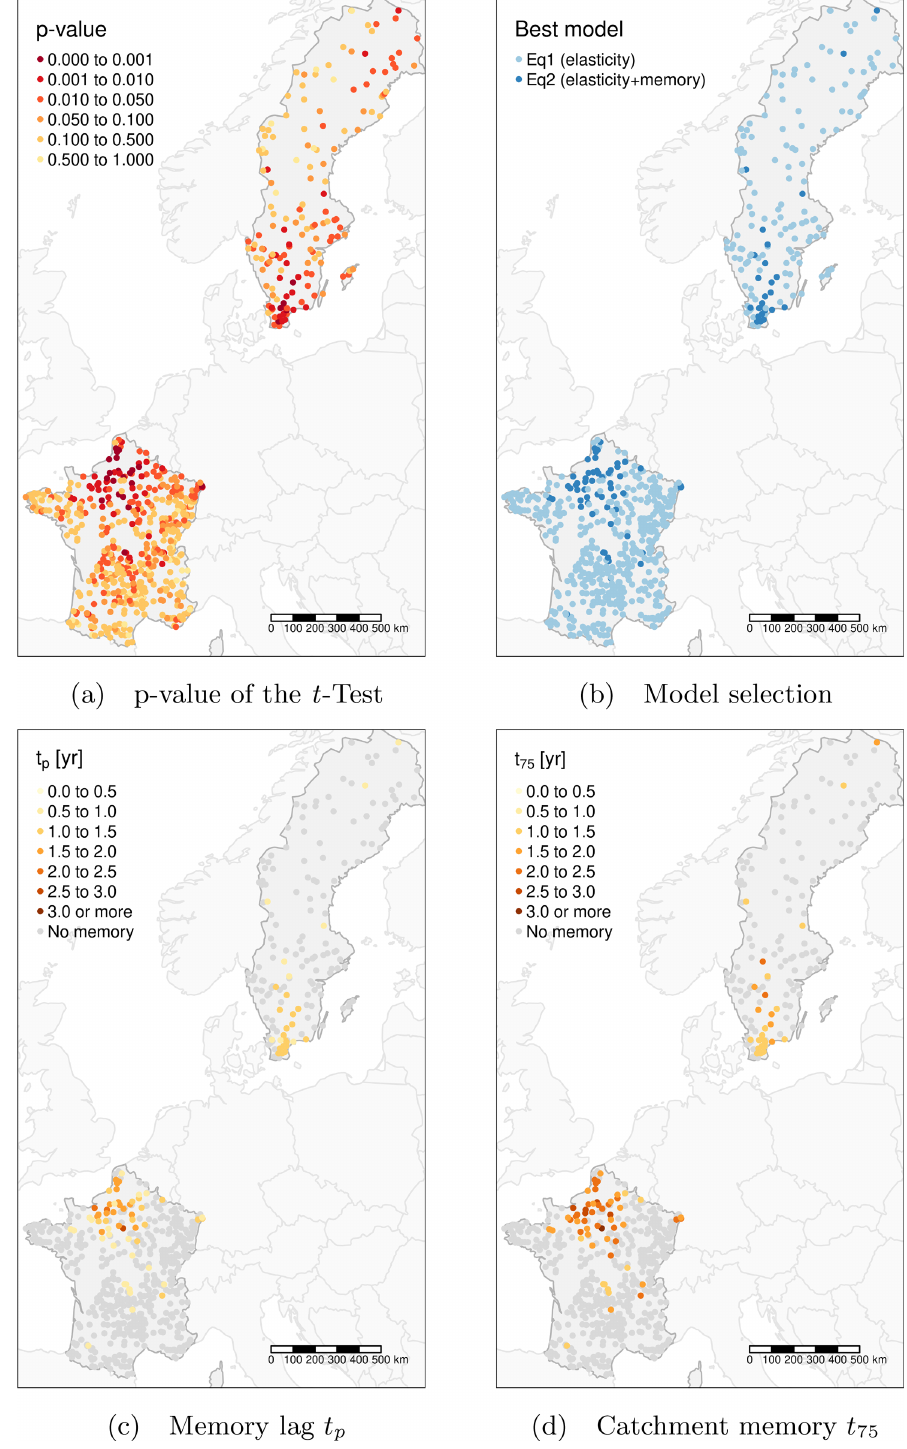
Figure 4. Spatial distribution of catchment memory over France and Sweden. Note that the model describing multi-year catchment memory (Eq. 2) is used only when the p value of the t test is below 0.01. Memory values are extracted from the Gamma distribution (see Sect. 2.4): t p is the time when the Gamma density function is maximum, and t 75 is the time when the cumulative distribution reaches